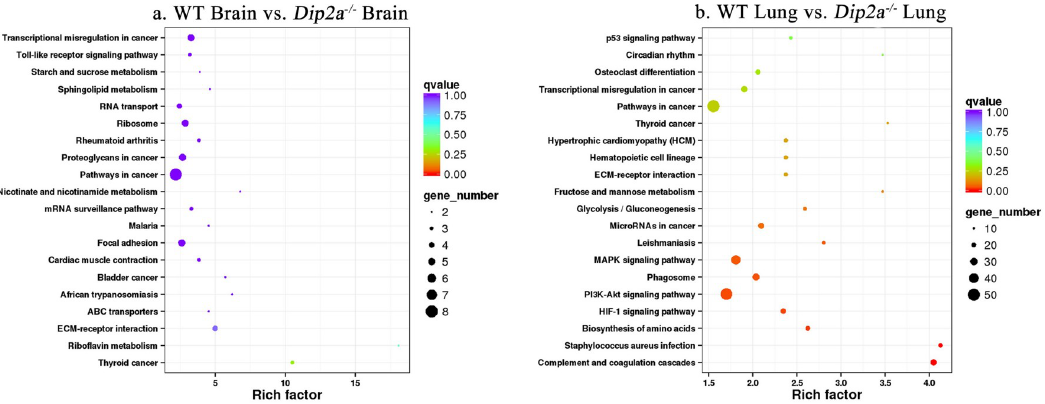
Fig 6. KEGG pathway enrichment scatter plot of DEGs. (a) WT brain vs. Dip2a -/- brain and (b) WT lung vs. Dip2a -/- lung. Each circle in the figure represents a KEGG pathway. The Y-axis represents name of the pathway and the X-axis indicates Enrichment Factor, indicating the proportion of the annotated genes to all genes in the